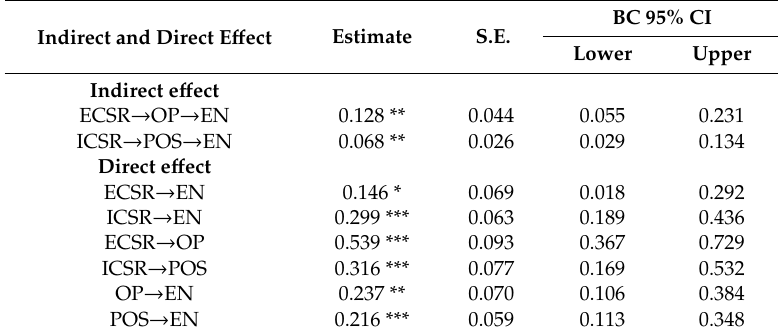
Table 3. Mediation analysis results.